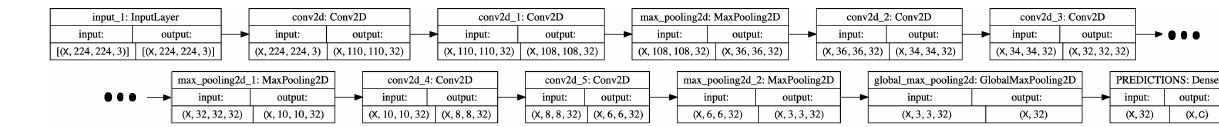
Figure 5. An illustration of the ThermalAttackNet architecture.